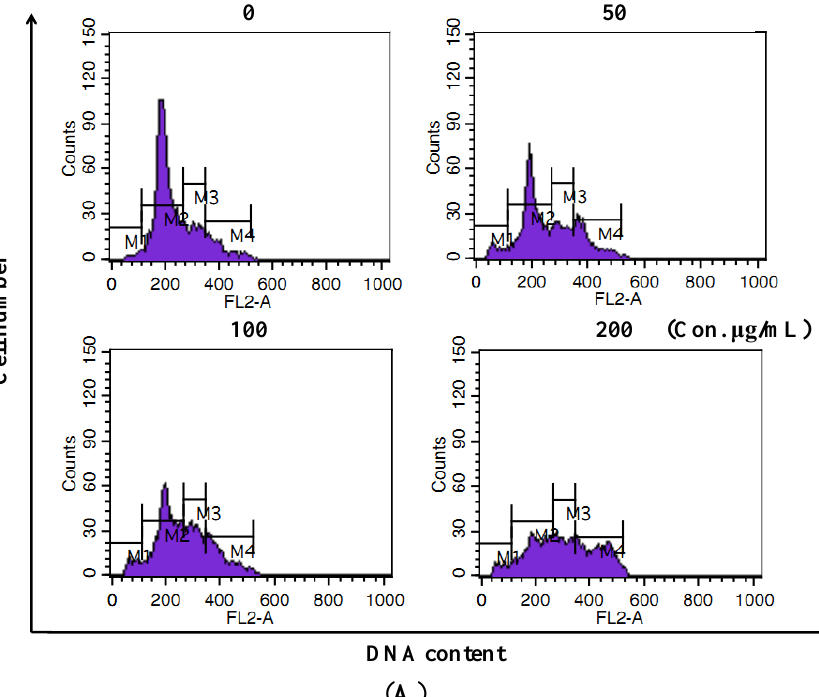
Figure 2. The effect of L. echinata on the HT-29 cell cycle. ( A ) Cells treated with different concentrations of L. echinata for 24 h and analyzed by flow cytometry after staining with PI; ( B ) Histogram showing the number of cells in each cell